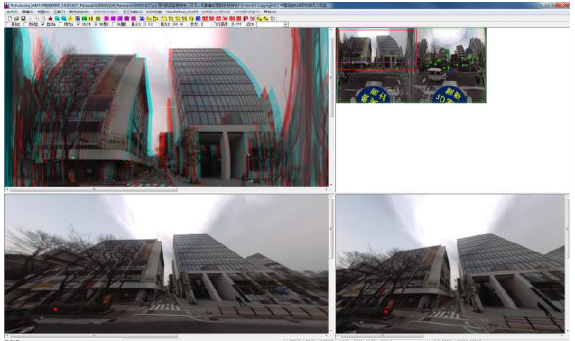
Figure 8. Anaglyphic stereo viewing for the resampled panoramic epipolar images.